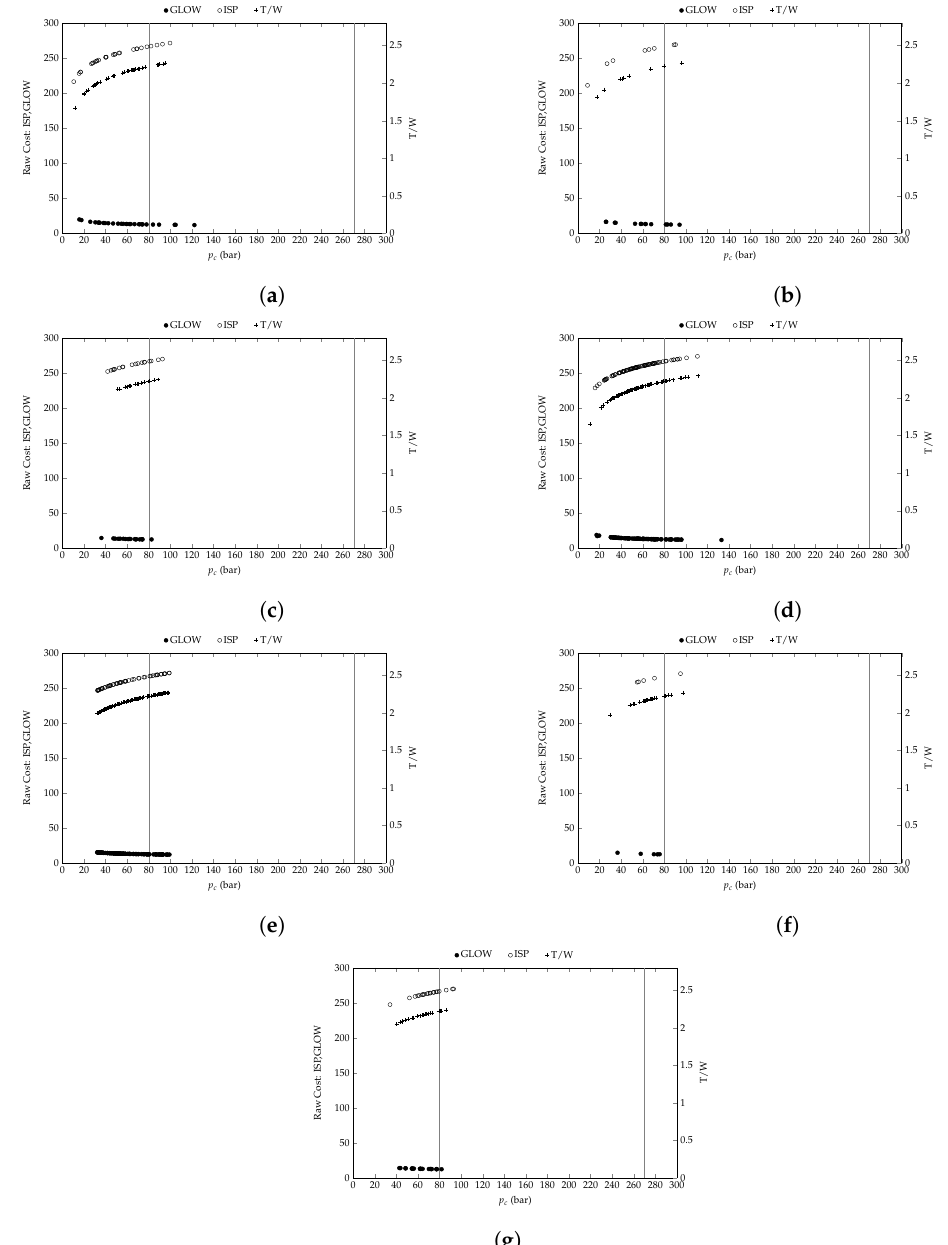
Figure 6. Optimization results for SC Cycle with mission ∆ V = 3800 m/s and H = 120 km using all 7 techniques and 3 OFs. ( a ) Nelder Mead (NM). ( b ) Simulated Annealing (SA). ( c ) Cuckoo Search Algorithm (CSA). ( d ) Particle Swarm Optimization (PSO). ( e ) Pigeon-Inspired Optimization (PIO). ( f ) Genetic Algorithm (GA). ( g )